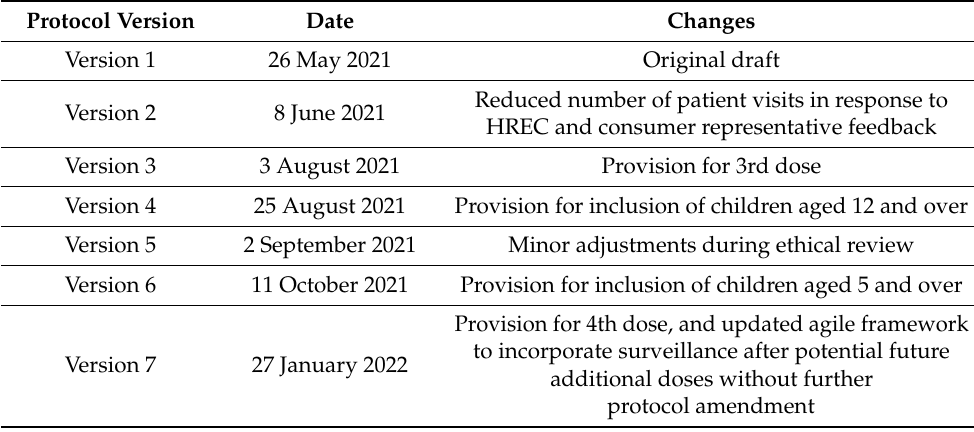
Table 2. Protocol